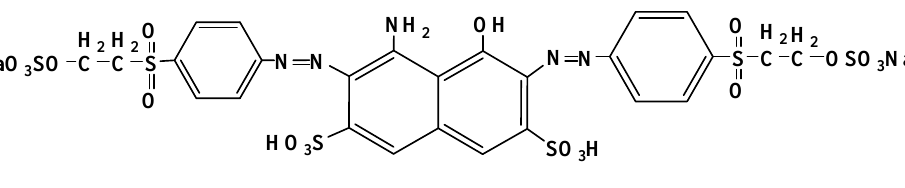
Figure 1. Chemical structures of Reactive Black 5